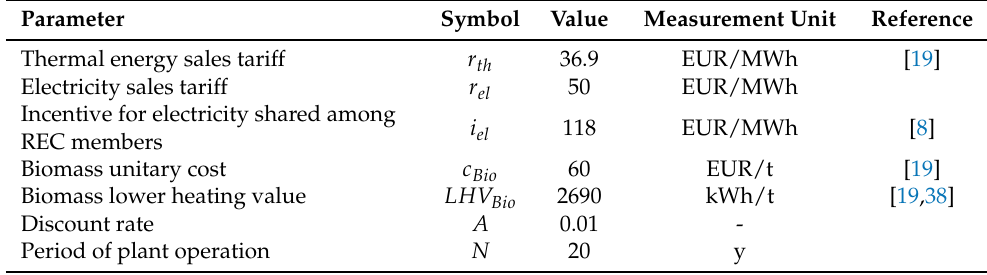
Table 10. Unitary prices and parameters considered to evaluate the REC operating costs.